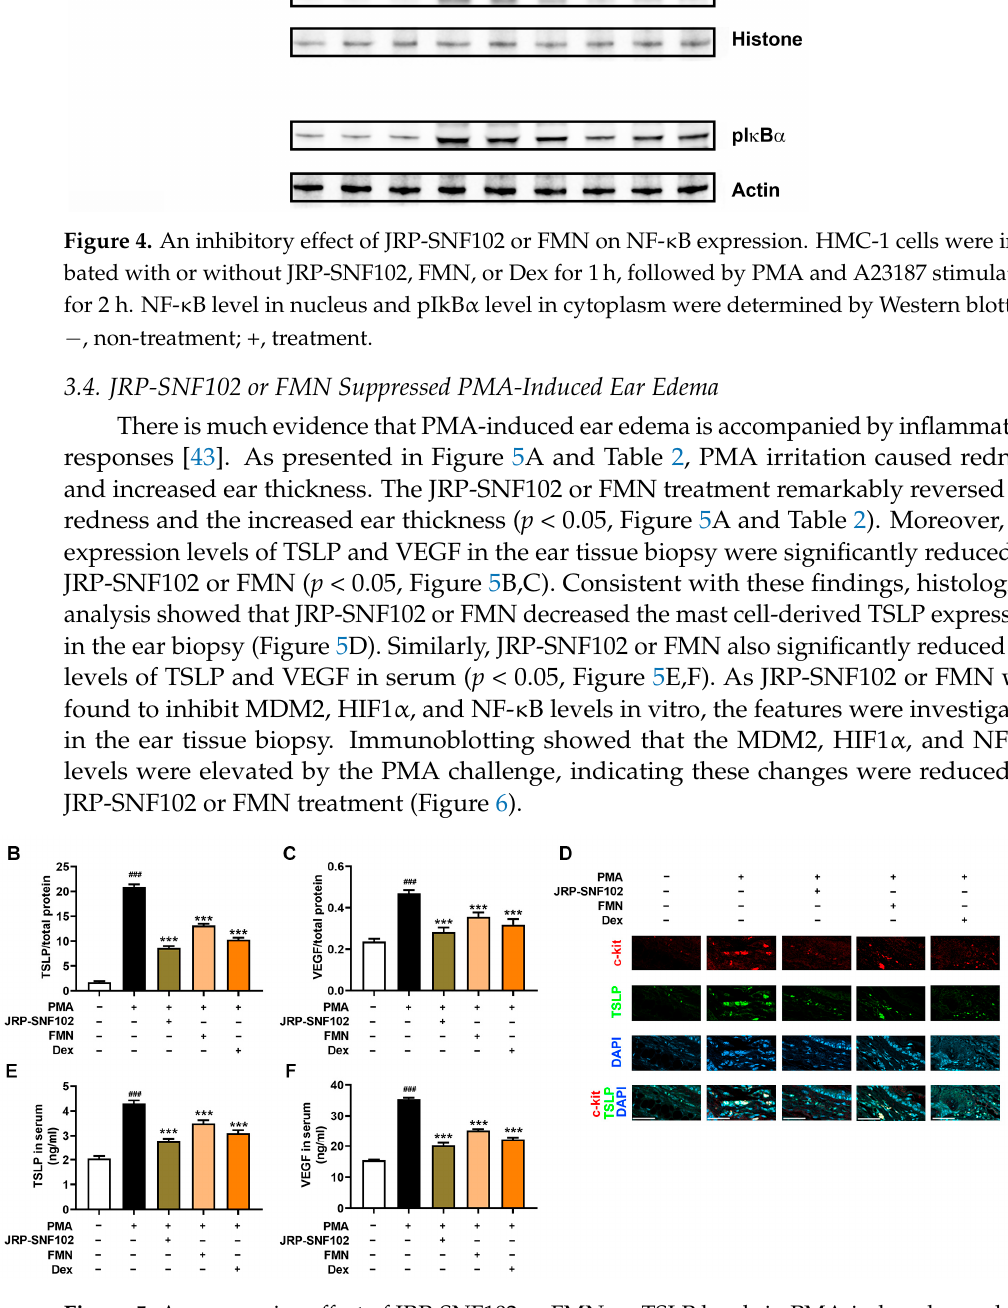
Figure 6. A suppressive effect of JRP-SNF102 or FMN on MDM2, HIF1 α , and NF- κ B levels in PMA- induced ear edema. The MDM2, HIF1 α , and NF- κ B levels were determined by Western blotting. -, non-treatment; +, treatment. Table 2. The increase of ear thickness. Group